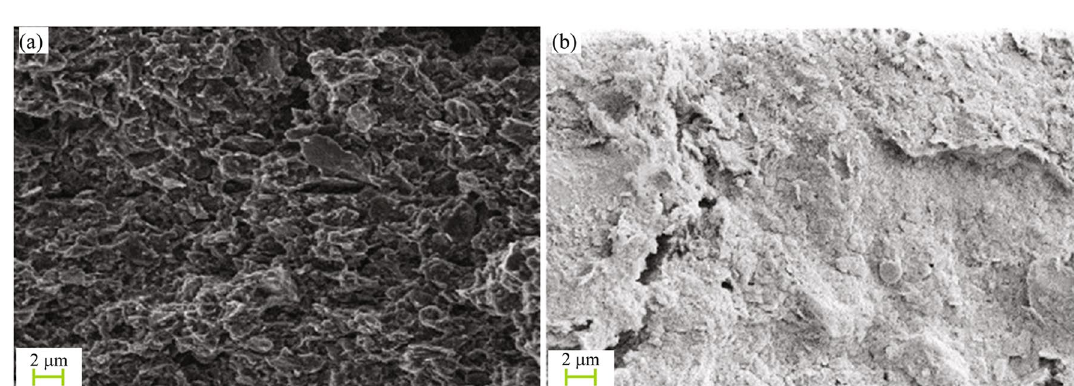
Figure 14. Structural soils. ( a ) Structural clay. ( b ) Structural red clay 2,38